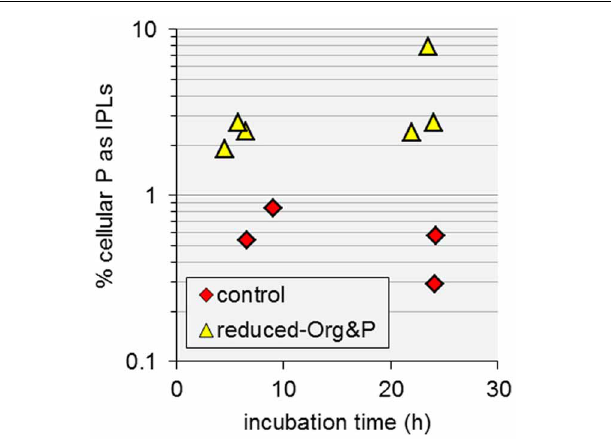
FIGURE 10 | The amount of cellular P stored as IPLs in T. kodakarensis . Cells harvested from reduced-Org&P media (triangles) contained more P as IPLs than control cells (diamonds); however there was large variability in the former, resulting in p > 0 .